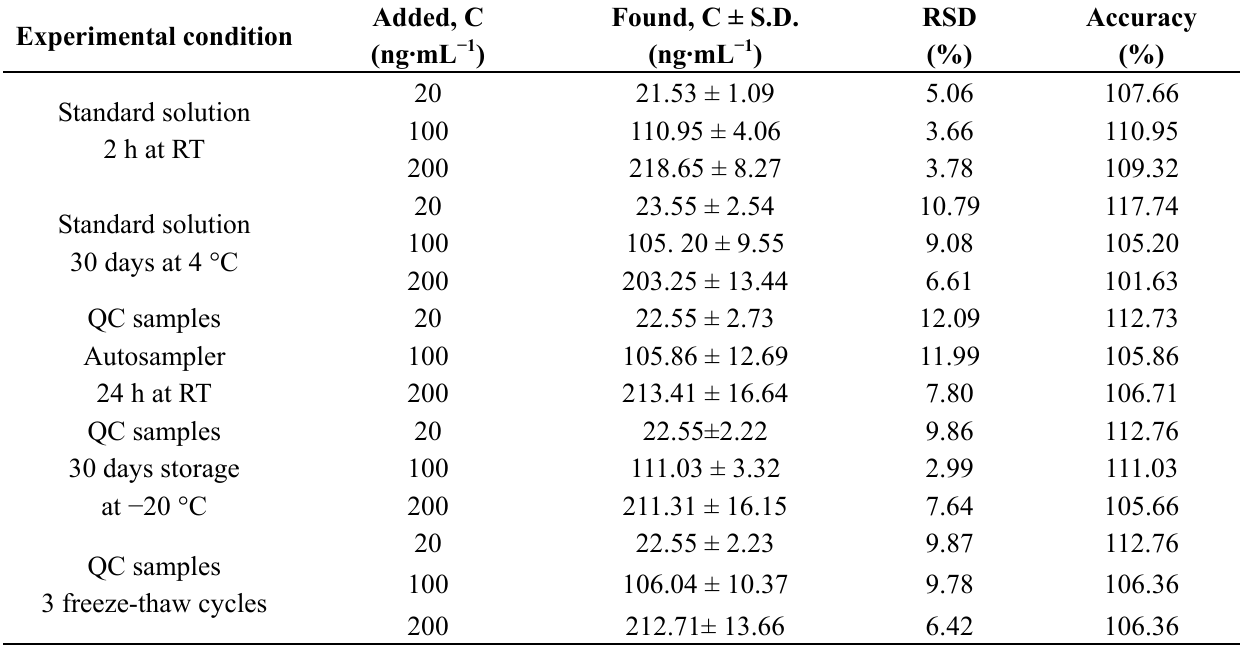
Table 5. Stability of p- tyrosol (n =